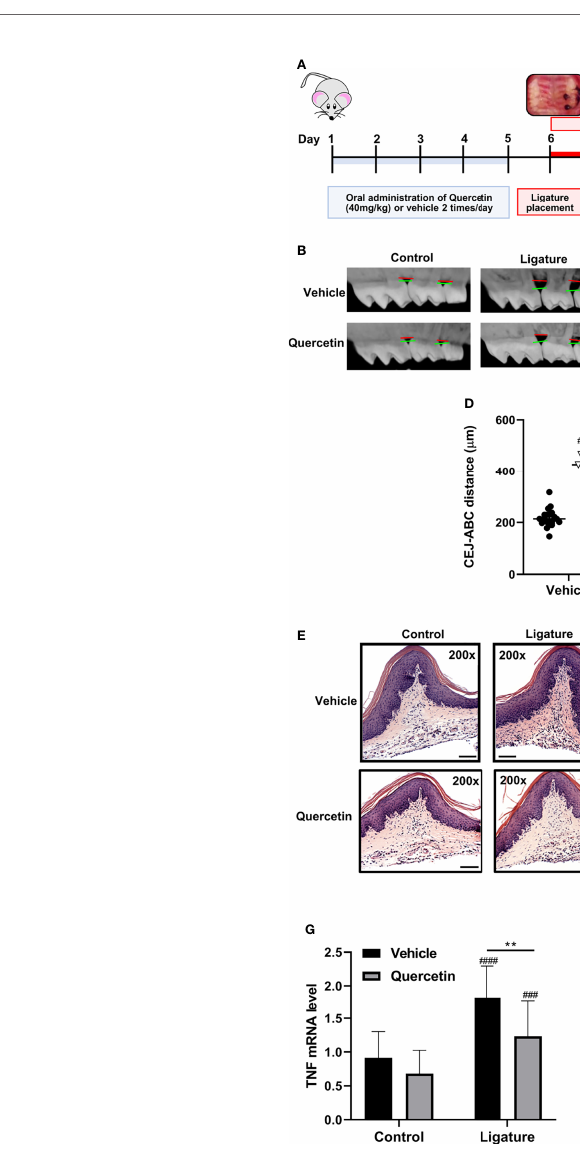
FIGURE 1 | Quercetin Treatment Decreases Periodontal In fl ammation and Bone Loss. (A) Schematic presentation demonstrating the experimental design system. In male C57BL/6J mice, silk 5-0 ligatures were placed on the left side of the maxilla interdentally between fi rst and second molars, while the right sides were left unligated as controls. Mice were treated with Quercetin by oral gavage or vehicle matched control six days prior to ligature placement and maintained with the same treatment regimen one-week post-ligation. Mice were euthanized and periodontal tissues were examined. (B) Representative images of 3D micro-CT reconstructions of periodontal bone in Quercetin treated and vehicle treated mice. The distance between horizontal lines represents the distance between cemental-enamel junction and alveolar bone crest. (C) Representative two-dimensional images of sagittal slice views of Quercetin-treated and vehicle-treated mice. Linear measurements were taken of the alveolar bone loss (ABL) in the interdental space from the cemental-enamel junction to alveolar bone crest. (D) Distance between the cemental-enamel junction and alveolar bone crest was analyzed and plotted to determine periodontal bone loss (n=37 mice for Quercetin treatment, n=21 mice for vehicle treatment). The average of 4 CEJ-ABC measurements were calculated per mouse. Individual mouse datapoints are plotted. Averages and standard deviations are shown. ****p ≤ 0.0001. #### Ligated gingival tissues versus corresponding experimental controls (p ≤ 0.0001). (E) Representative images from H&E stained histological sections from gingival tissues derived from ligated and control periodontium in Quercetin-treated and vehicle-treated mice. (F) Quantitative analysis of in fl ammatory cell in fi ltrate in the periodontium. Positive cells were counted per µm 2 gingival connective tissue. Data are representative of three independent experiments, with a minimum of seven mice analyzed in each treatment group per experiment. Averages and standard deviations are shown. **p ≤ 0.01, ****p ≤ 0.0001. (G, H) Gingival tissues derived from ligated and control periodontium in Quercetin treated and vehicle treated mice were digested and applied to RNA preparation. The mRNA levels of mTNF (G) , mIL-6 (H) were determined with qRT-PCR and the relative mRNA expression levels were plotted (n=11 for vehicle treatment, n=26 for Quercetin treatment). Averages and standard deviations are shown. **p ≤ 0.01, ***p<0.001, ****p ≤ 0.0001. #### Ligated gingival tissues versus corresponding experimental controls (p ≤ 0.0001). ### Ligated gingival tissues versus corresponding experimental controls (p ≤ 0.001). ## Ligated gingival tissues versus corresponding experimental controls (p ≤